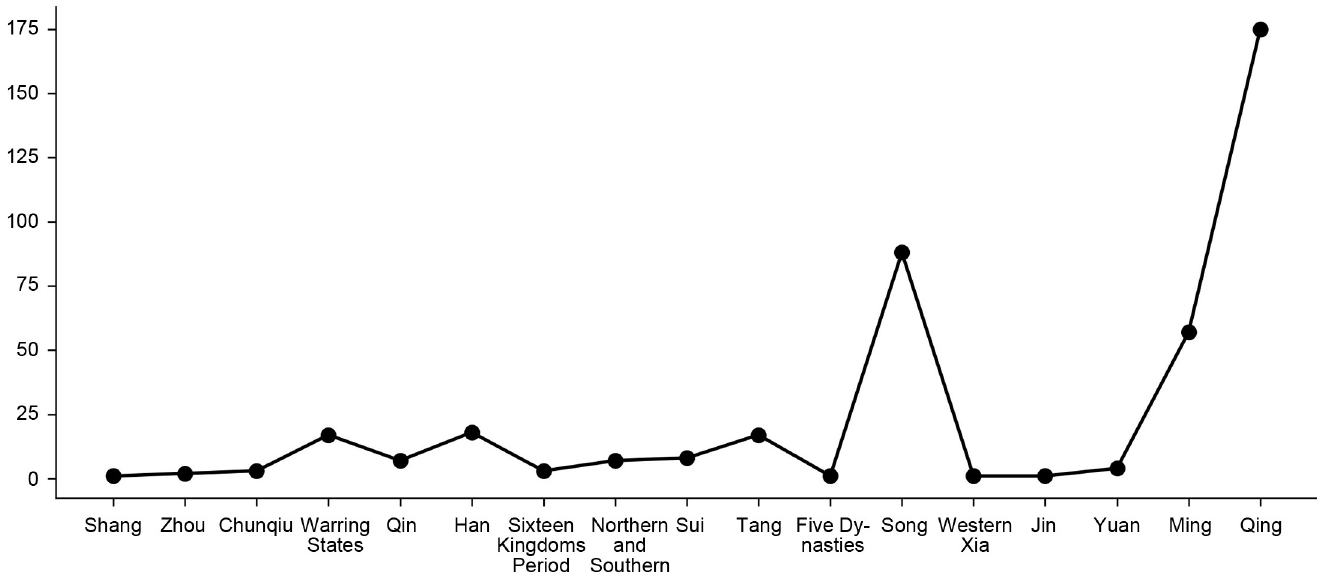
Fig 13. The chronological trend of fort-type